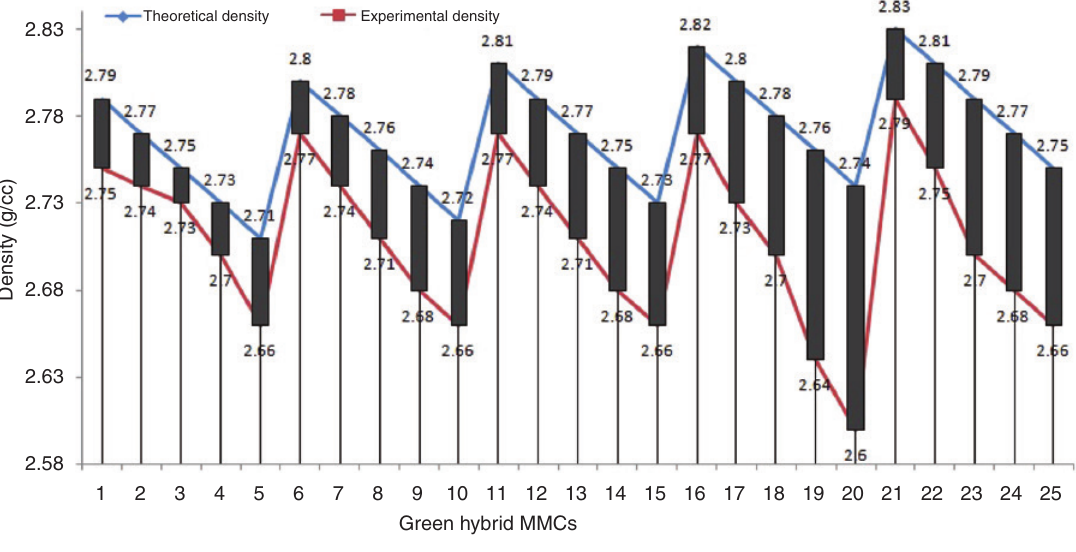
Figure 10: Density and porosity analysis of hybrid green MMCs.